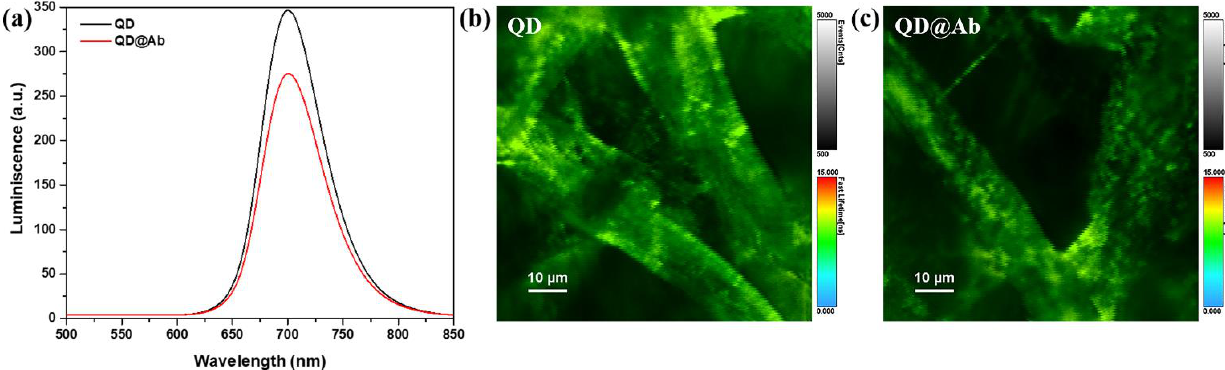
Figure 4. ( a ) Luminescence spectra of QD (black spectrum) and QD@Ab (red spectrum) in PBS solution ( λ excitation = 450 nm); Corresponding FLIM images of QD ( b ) and QD@Ab ( c ) dropped onto the paper platform ( λ excitation = 405 nm).